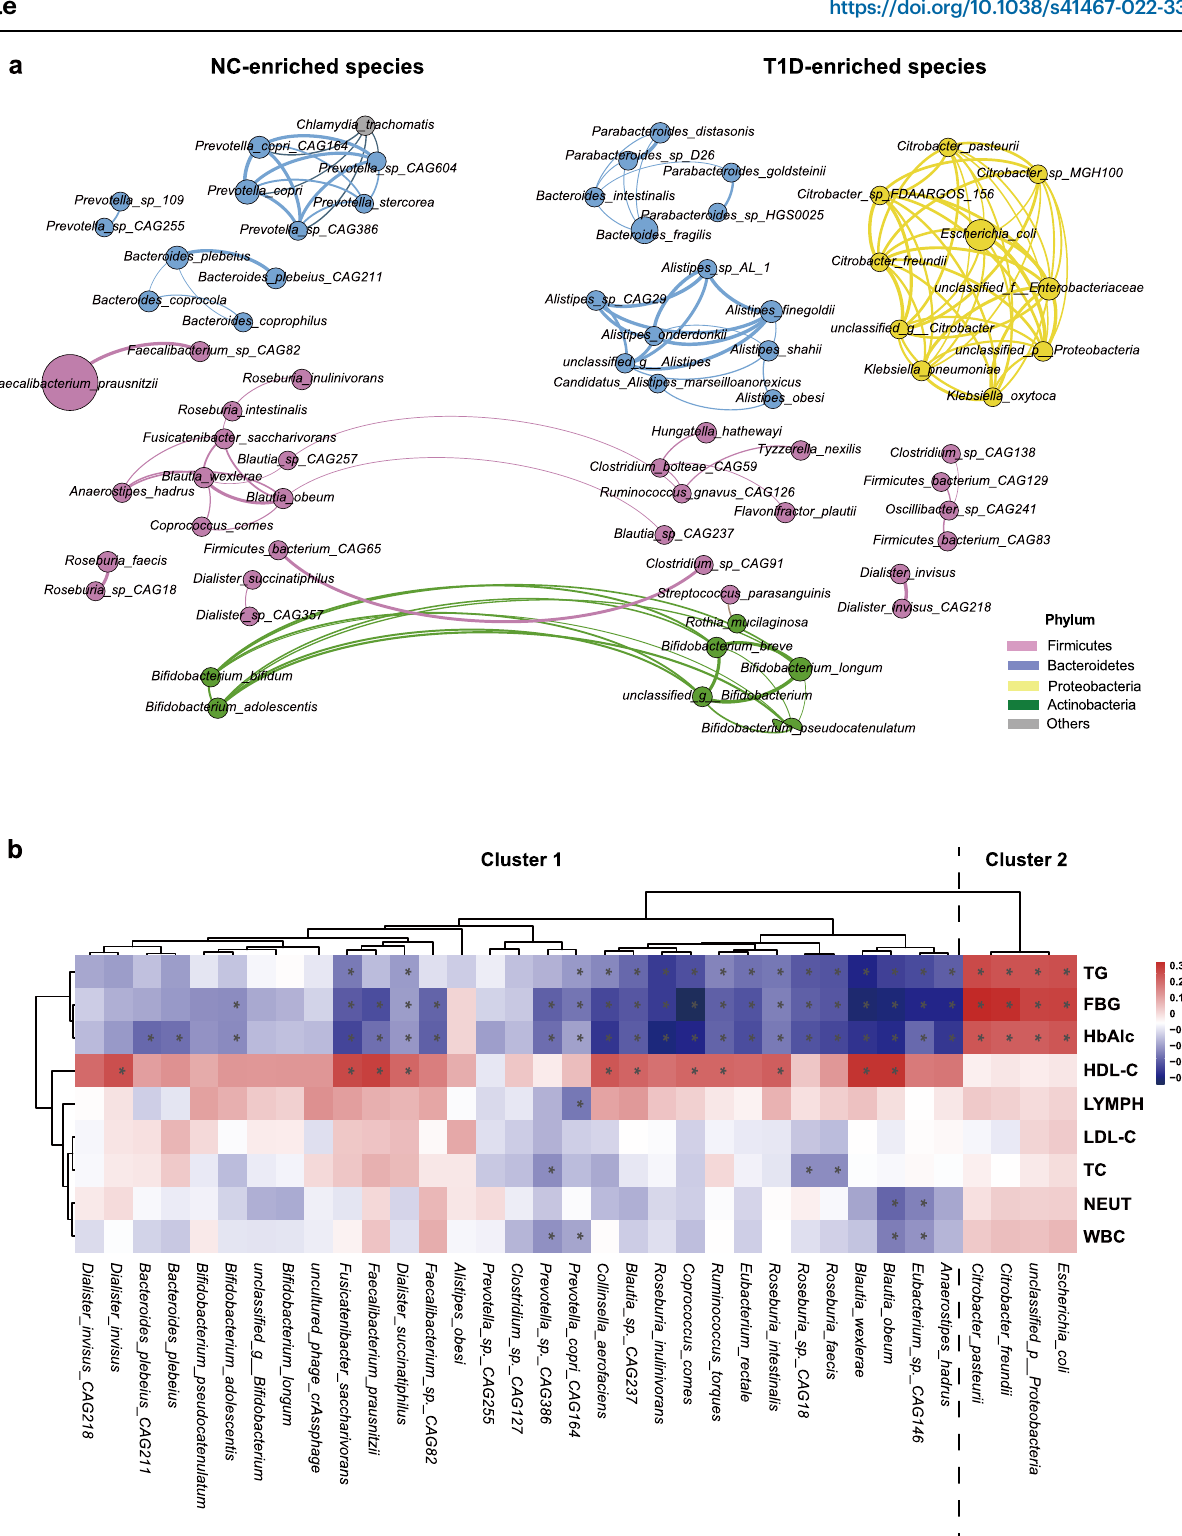
0.6 between each other. NC-enriched species are arranged on the left, while T1D- enriched species are arranged on the right. b Heatmap of the Spearman ’ s correla- tion between clinical indices and discriminatory species (*FDR<0.05). Red squares indicate positive correlations, whereas blue squares indicate negative correlations. NC: n =77, T1D: n =64. *FDR<0.05. Source data are provided as a Source Data fi